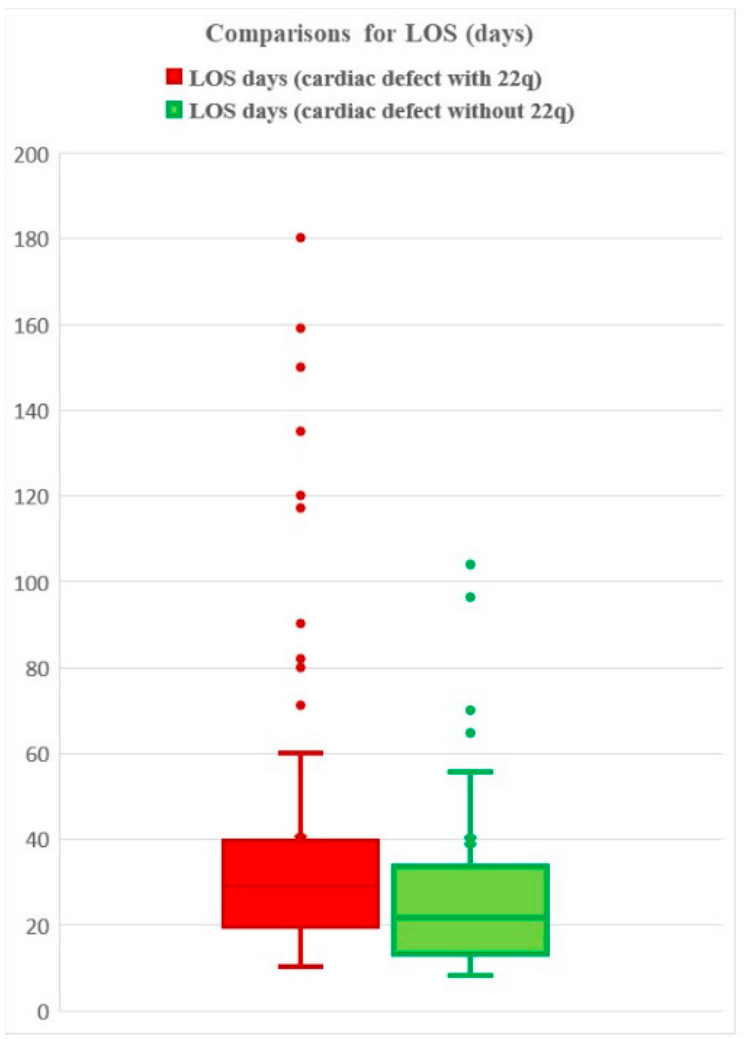
Figure 4. Length of Hospital Stay for those patients with IAA with and without 22q11.2DS.